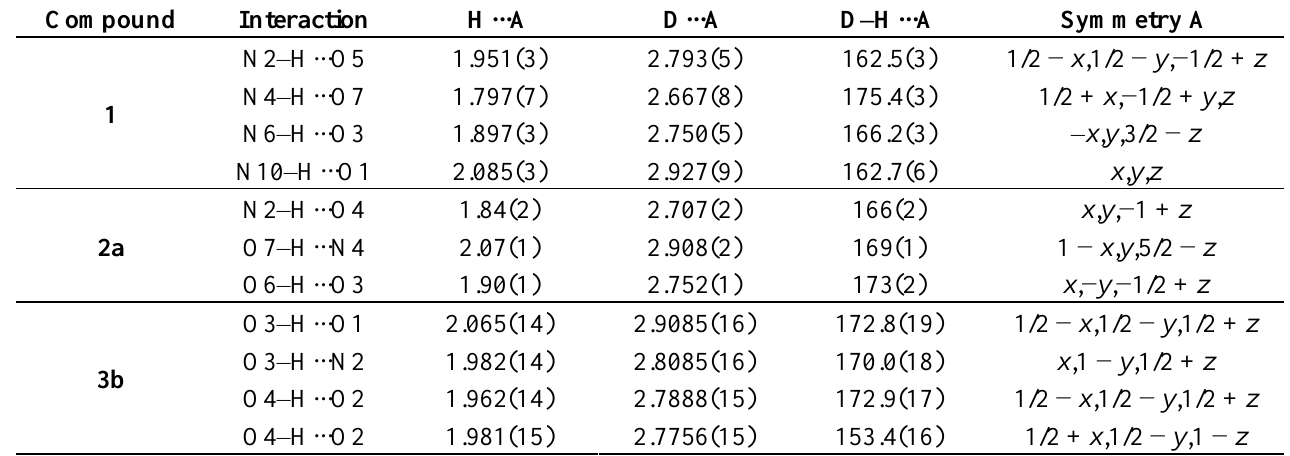
Table 2. Hydrogen bond parameters